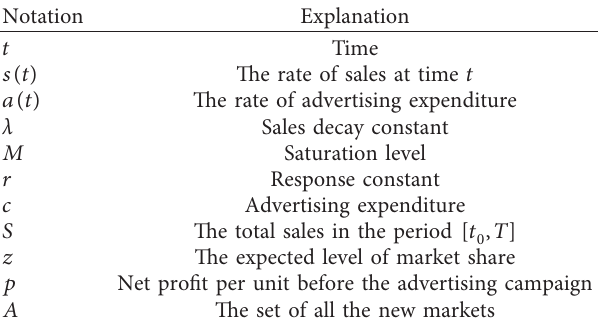
Table 1: Explanations of notations used in this